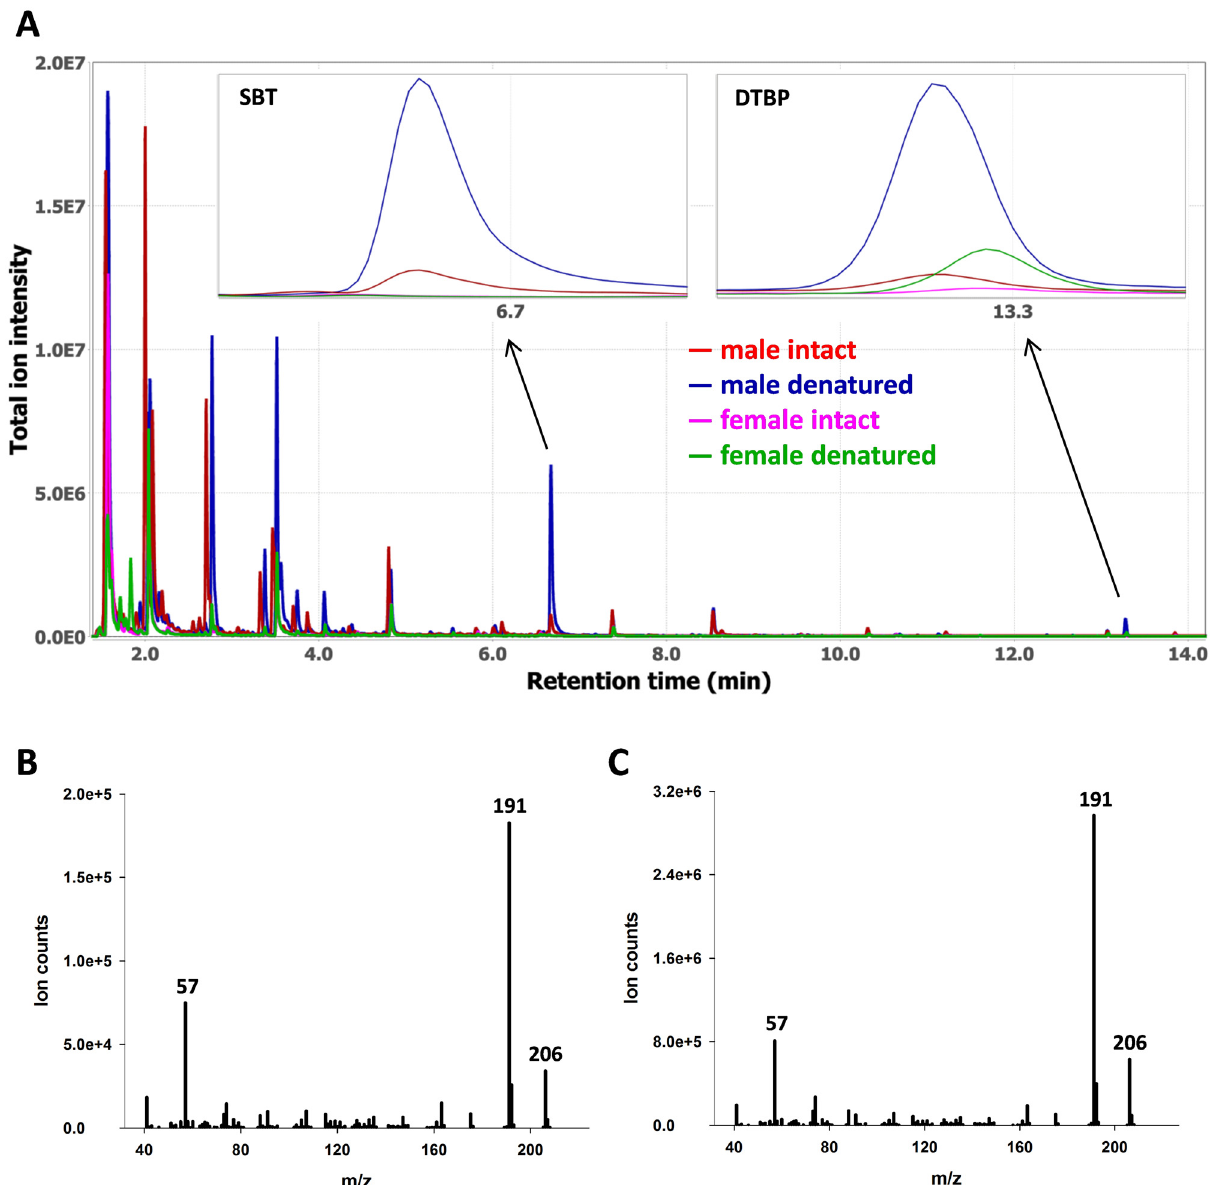
Fig 1. Representative overlaid chromatograms acquired from intact and denatured male and female mouse urine samples (A), the mass spectra of DTBP obtained from a male mouse urine sample (B) and a synthetic standard (C). The intensity distributions of DTBP and SBT in the urine samples are shown in the insets (A). Guanidine hydrochloride (GdmCl) was added to urine to denature urinary